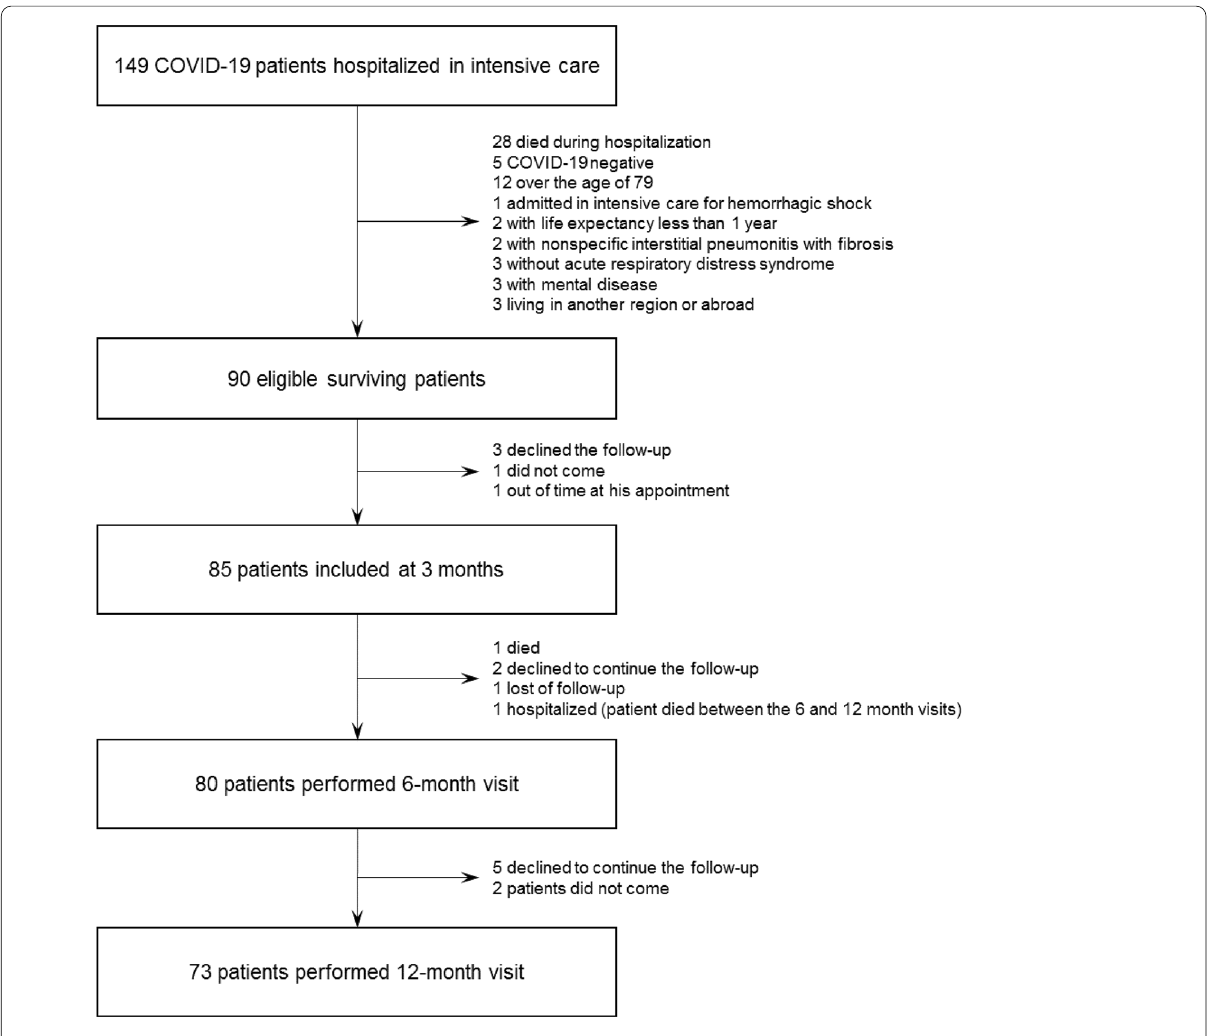
Fig. 1 Flowchart of patients with COVID‑19. Enrollment of patients hospitalized in intensive care unit for severe Sars‑COV‑2 and follow‑up for the first 12 months after symptoms